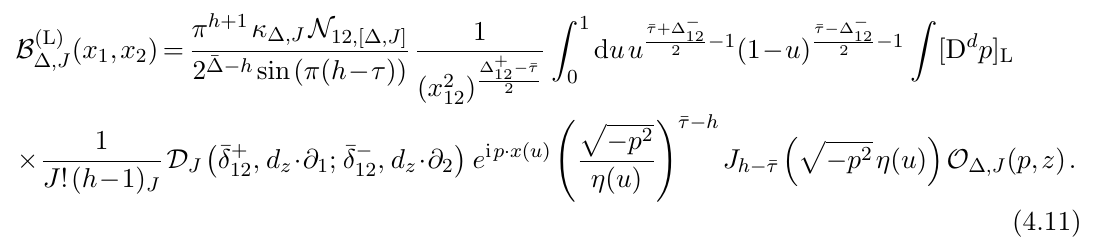
JHEP04(2020)139 in Lorentzian AdS (cid:1)